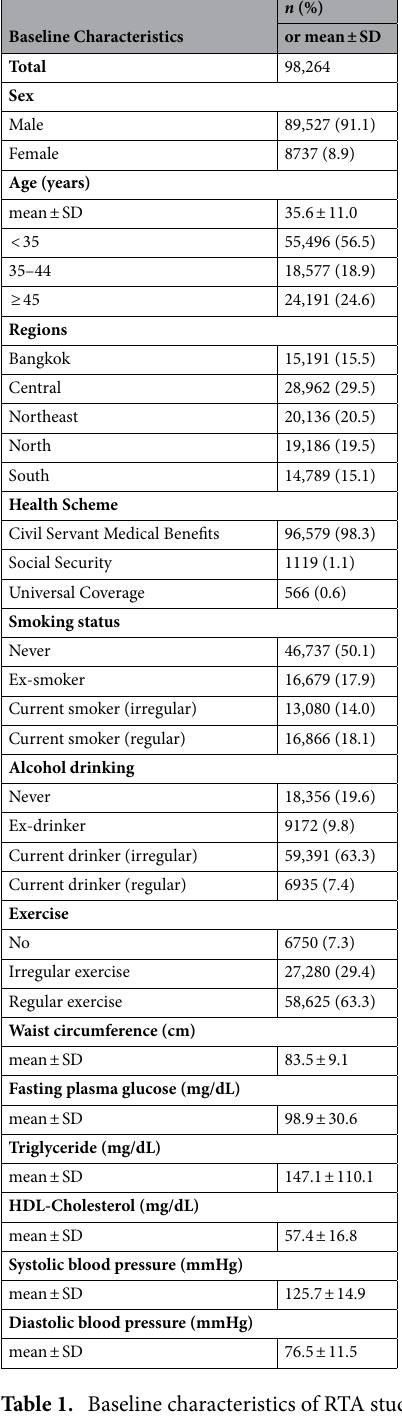
Table 1. Baseline characteristics of RTA study participants